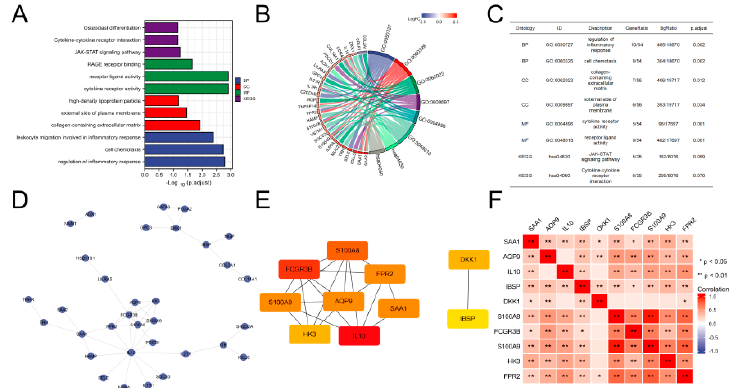
Figure 2. Functional enrichment analysis of differentially expressed genes. ( A – C ) GO and KEGG analysis. ( D , E ) Protein interaction network diagram. The darker the template color, the greater the interaction score. ( F ) Heatmap of key genes with expression correlations.